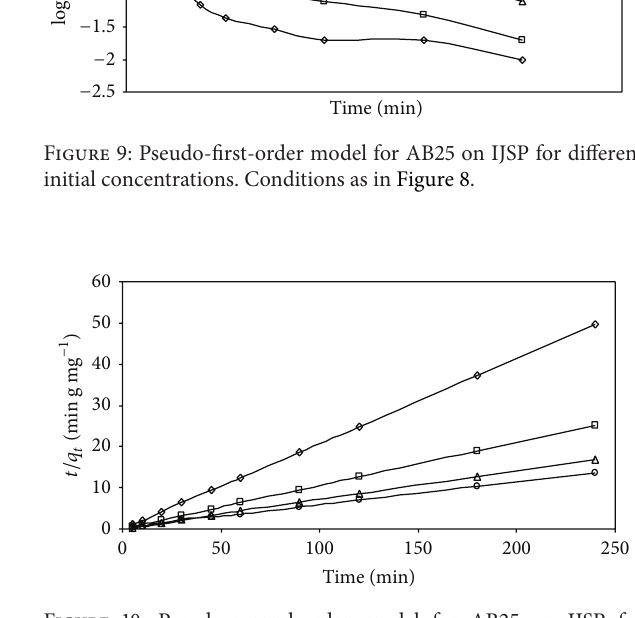
Figure 10: Pseudo-second-order model for AB25 on IJSP for different initial concentrations. Conditions as in Figure